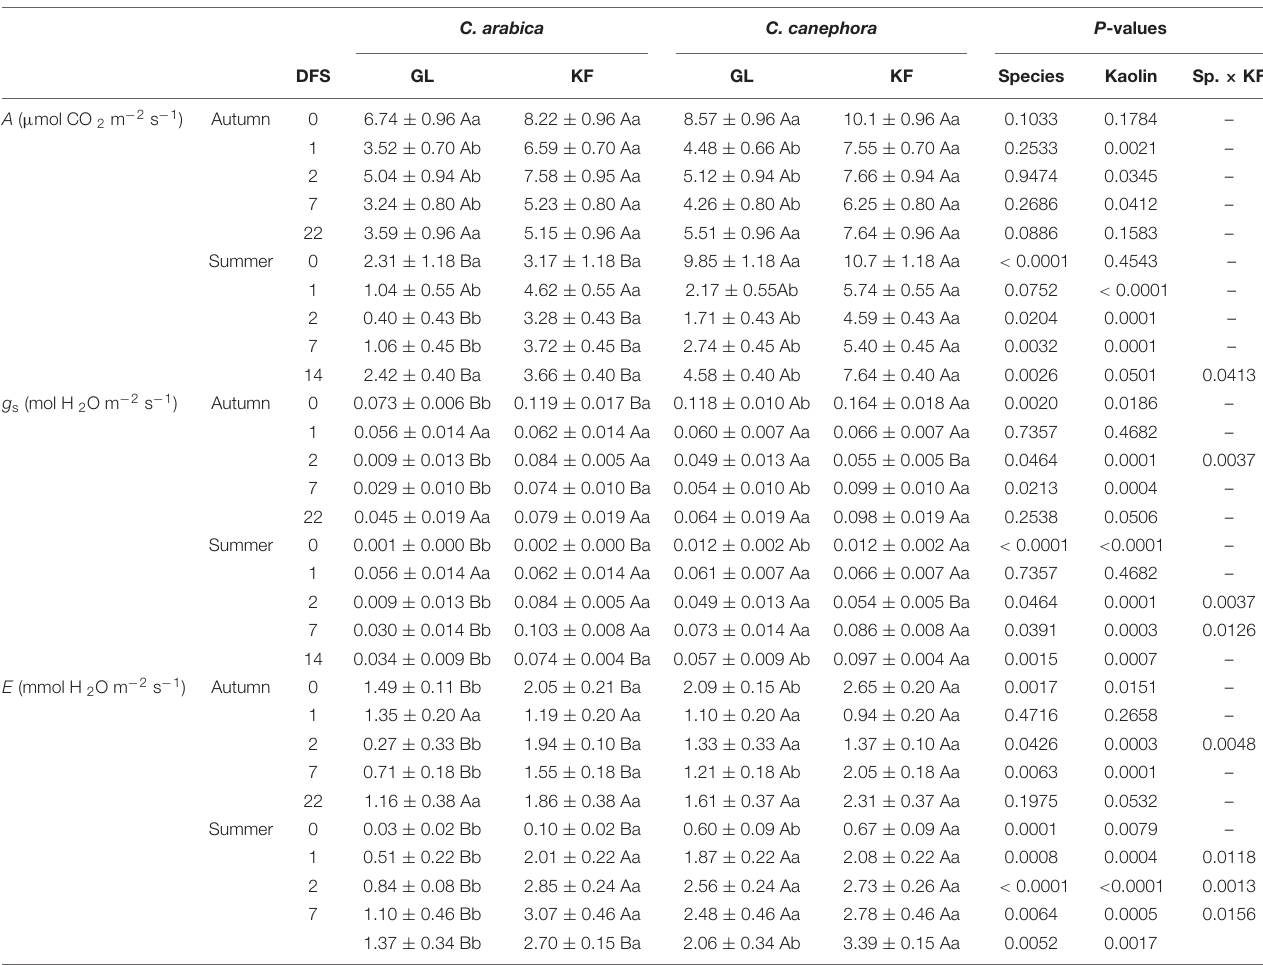
TABLE 2 | The instantaneous leaf gas exchanges measurement included net CO 2 assimilation rate ( A , µ mol CO 2 m − 2 s − 1 ), stomatal conductance ( g s , mmol H 2 O m − 2 s − 1 ), transpiration rate ( E , mmol H 2 O m − 2 s − 1